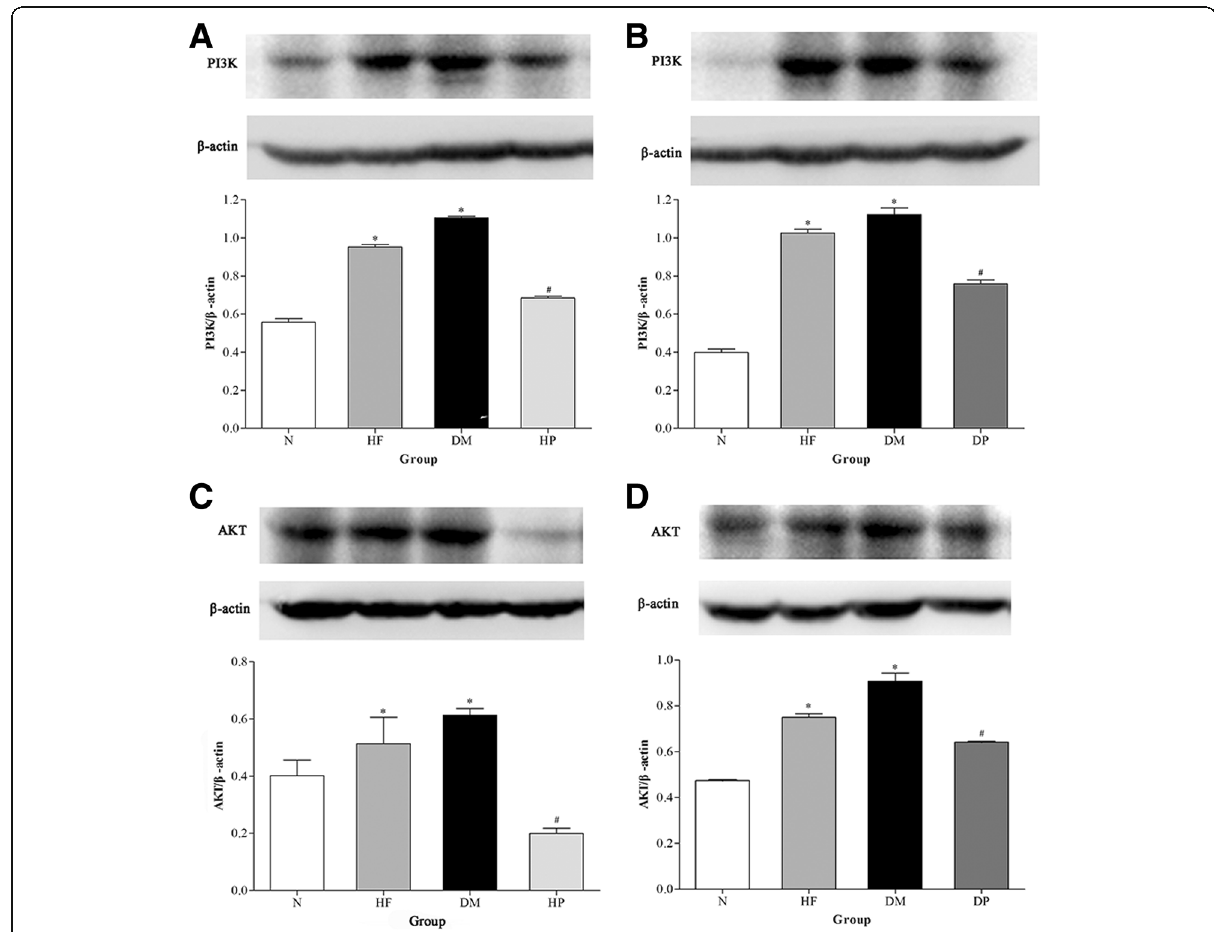
Fig. 4 Supplement of RPFC decreased PI3K and AKT in high fat fed rats and DM rats. Protein expression of PI3K a and b , and AKT c and d . Renal PI3K and AKT increased in the kidneys of the HP and DM group rats in comparison to that of the normal group (* P < 0.05). Renal AKT decreased in the kidneys of the HP and DP group rats in comparison to that of the HF and DM group ( # p < 0.05). Bars represent mean ± SD